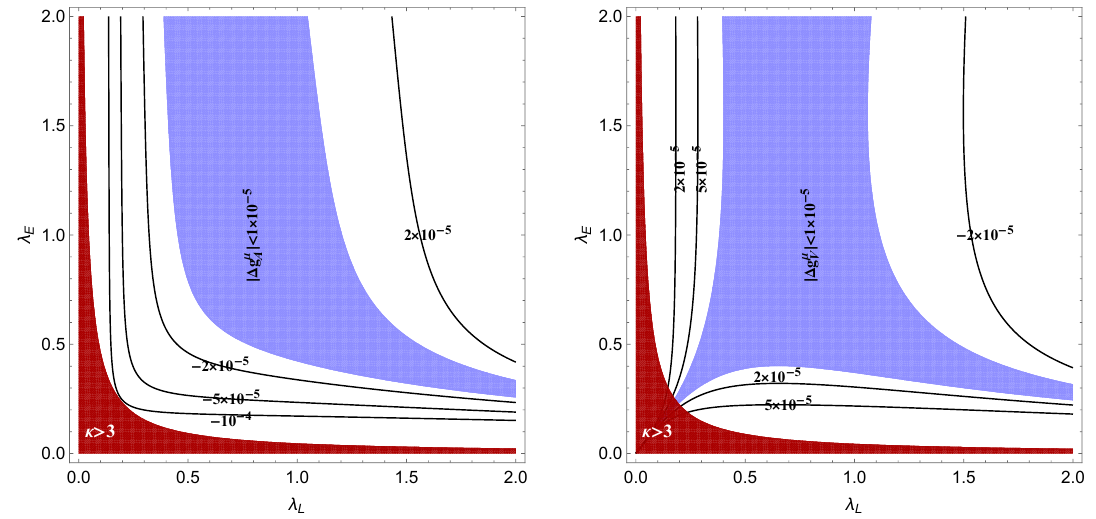
Figure 3 . Modification of g µ λ II for fixed hypercharge X = 0 . In both cases regions in parameter space where the modification L stays below 10 − 5 are marked in blue, those with coupling | κ | > 3 in